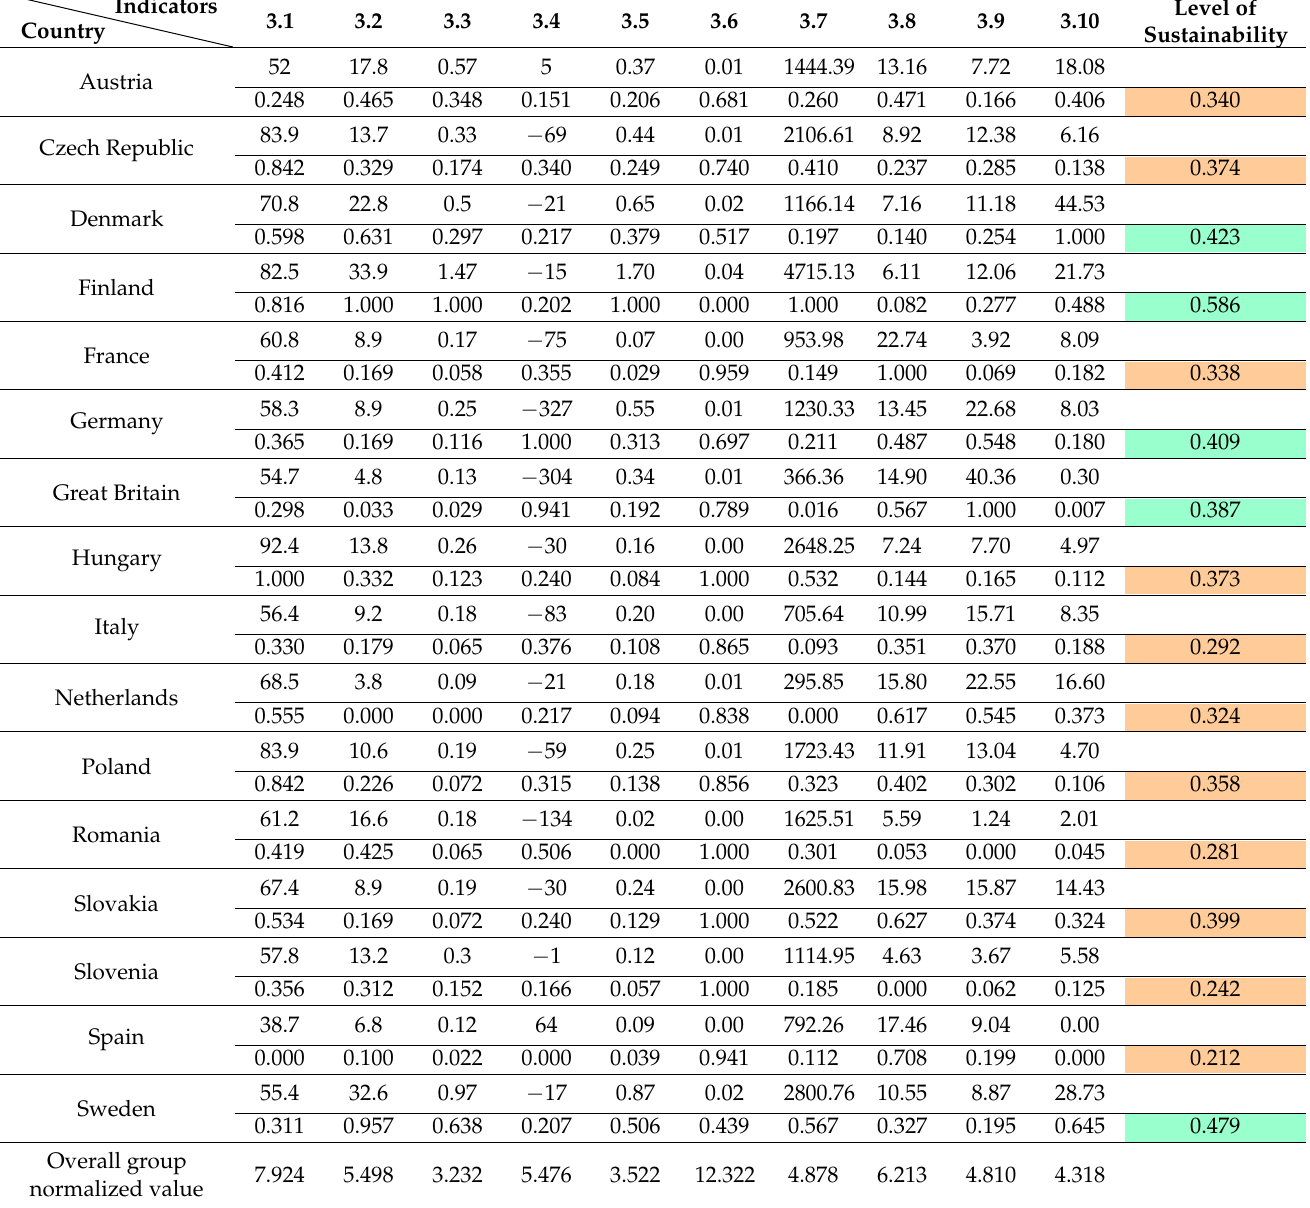
Table 5. Level of sustainability in the bioenergy field.